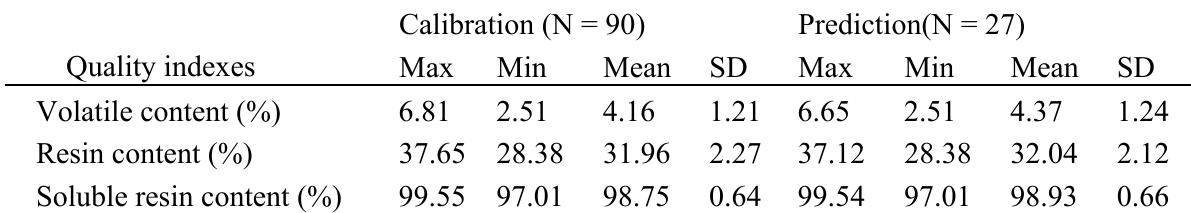
Table 1b. Statistical parameter of calibration set for quality indexes of the alkali-free cloth.